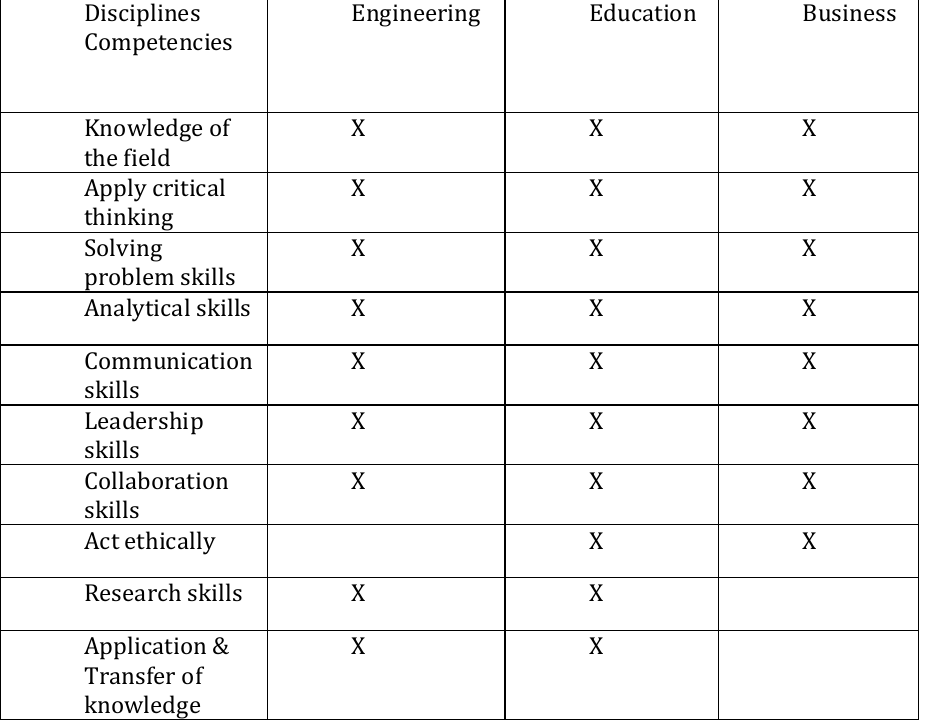
Competencies Shared by